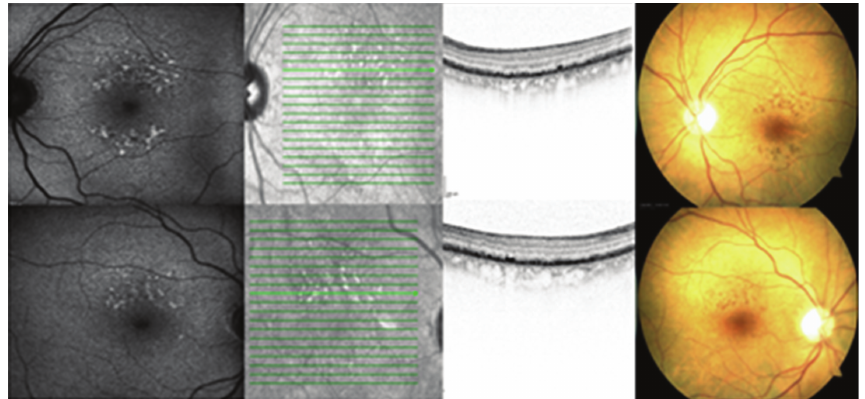
Figure 1: Autofluorescent imaging, SD-OCT and colour fundus photography of both eyes. Note the marked increase of autofluorescense and changes at the RPE level on OCT. (Light green denotes scanning